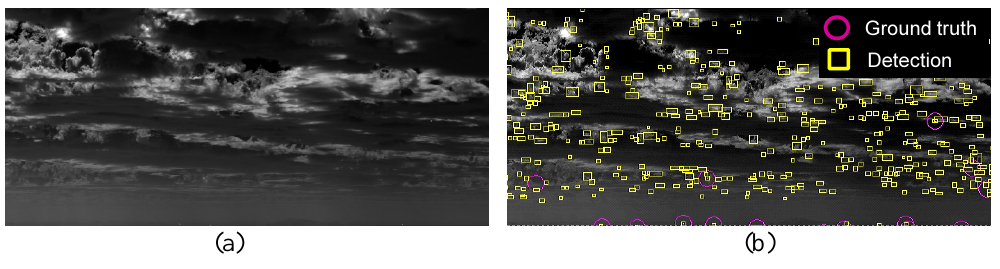
Figure 12. Problems of false alarms caused by cloud clutter: ( a ) original infrared image; ( b ) M-MSF + hysteresis threshold-based constant false alarm rate (H-CFAR) detection.